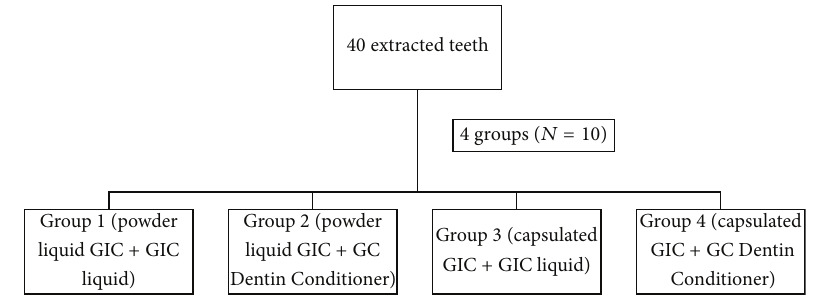
Figure 1: Distribution of samples.